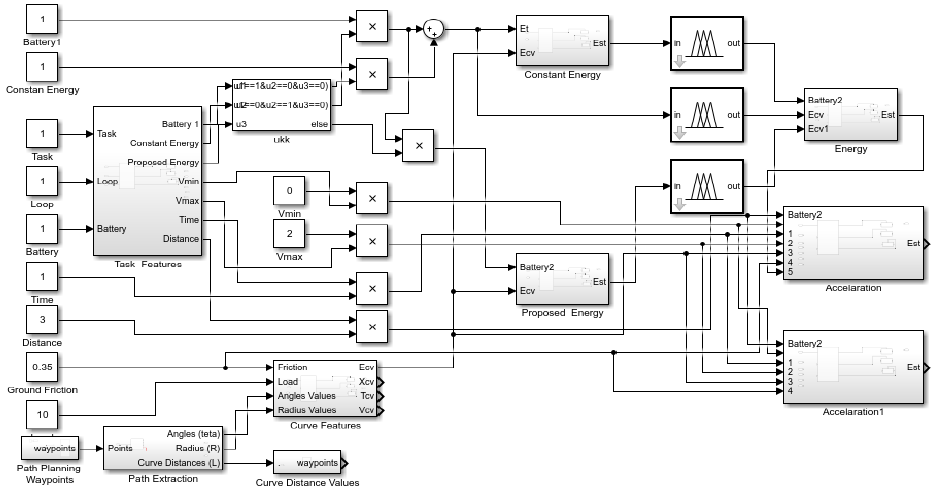
Figure 8. Speed–acceleration MATLAB/SIMULINK fuzzy control structure.